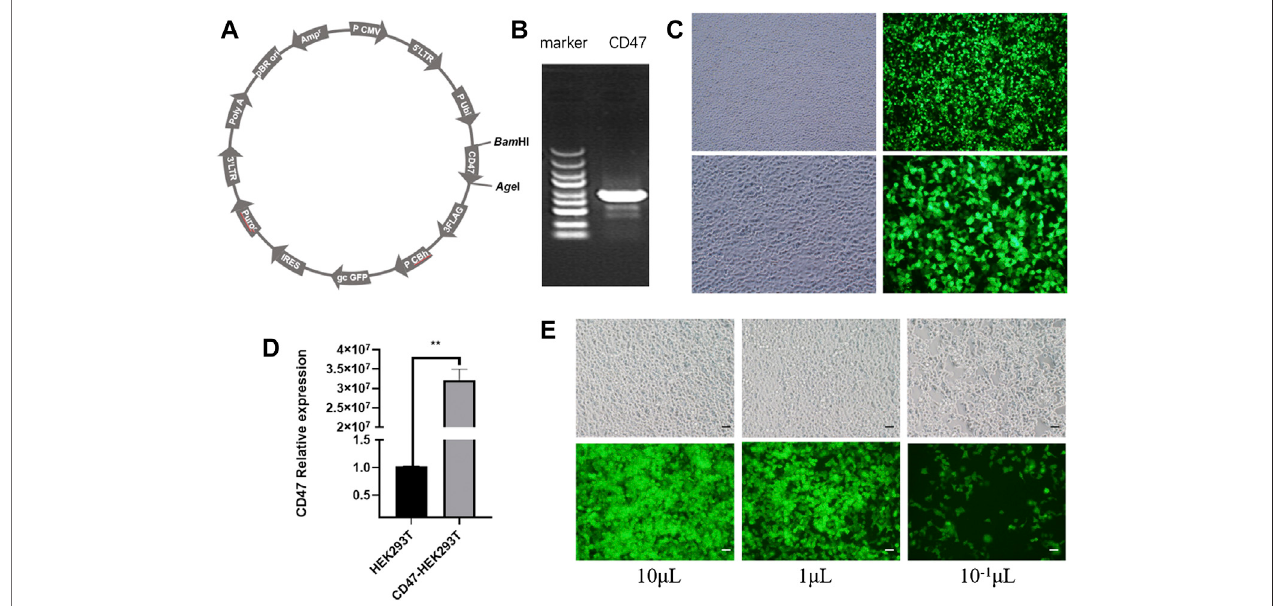
FIGURE 1 | (A) Vector plasmid with CD47 overexpression. (B) Agarose gel electrophoresis of the target gene (CD47). (C) Phase contrast microscopy (left) and fl uorescence microscopy (right) of HEK293T cells that were transfected with the CD47 overexpression plasmid. (D) Relative expression of CD47 (qPCR) in HEK293T cells before and after plasmid transfection. N = 3, ** p < 0.01. (E) Phase contrast microscopy (top) and fl uorescence microscopy (bottom) of HEK293T cells with the CD47 overexpression lentiviral vector after transfection. Scale bar: 500 μ